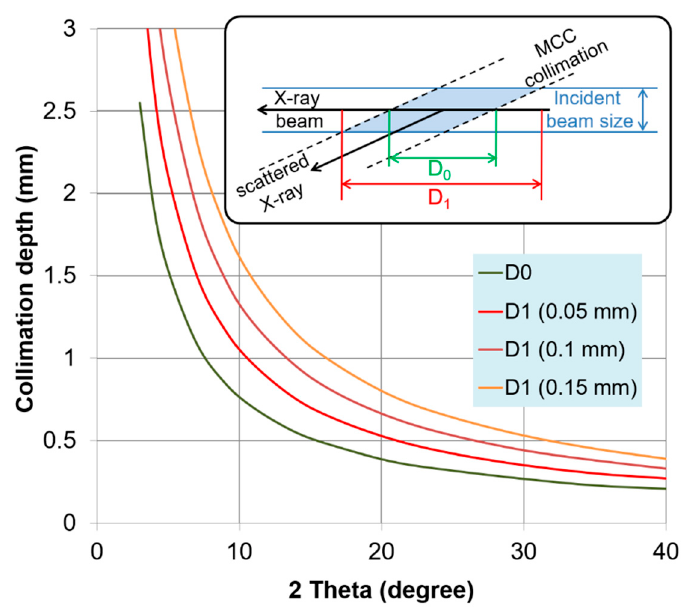
Figure 4. Calculated collimation depth at the sample center (D 0 ) and the maximum collimation depth (D 1 ) that takes into account the size of the incident beam. As an example, with an incident beam size of 0.05 mm (red curve), a sample with a diameter > 1.05 mm can be used without being interfered by crystalline peaks from the surrounding pressure media at two-theta angles greater than 10°.